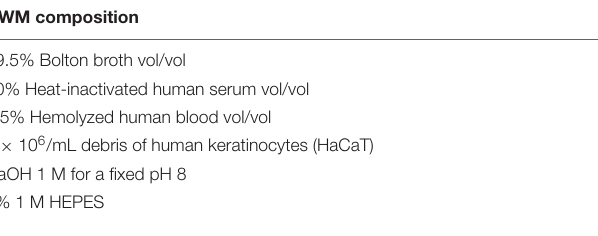
TABLE 2 | Composition of the chronic wound medium